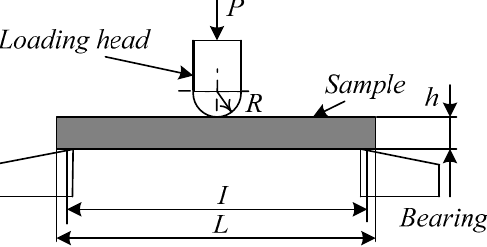
Figure 3. Three-point bending test method diagram. P —Load, I —Sample span, L —Length of the sample, h —Sample thickness, R —Radius of the loading head.